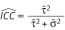
Fig 2 Formula for proportion of total variation in indicator that is accounted for by variation between practices